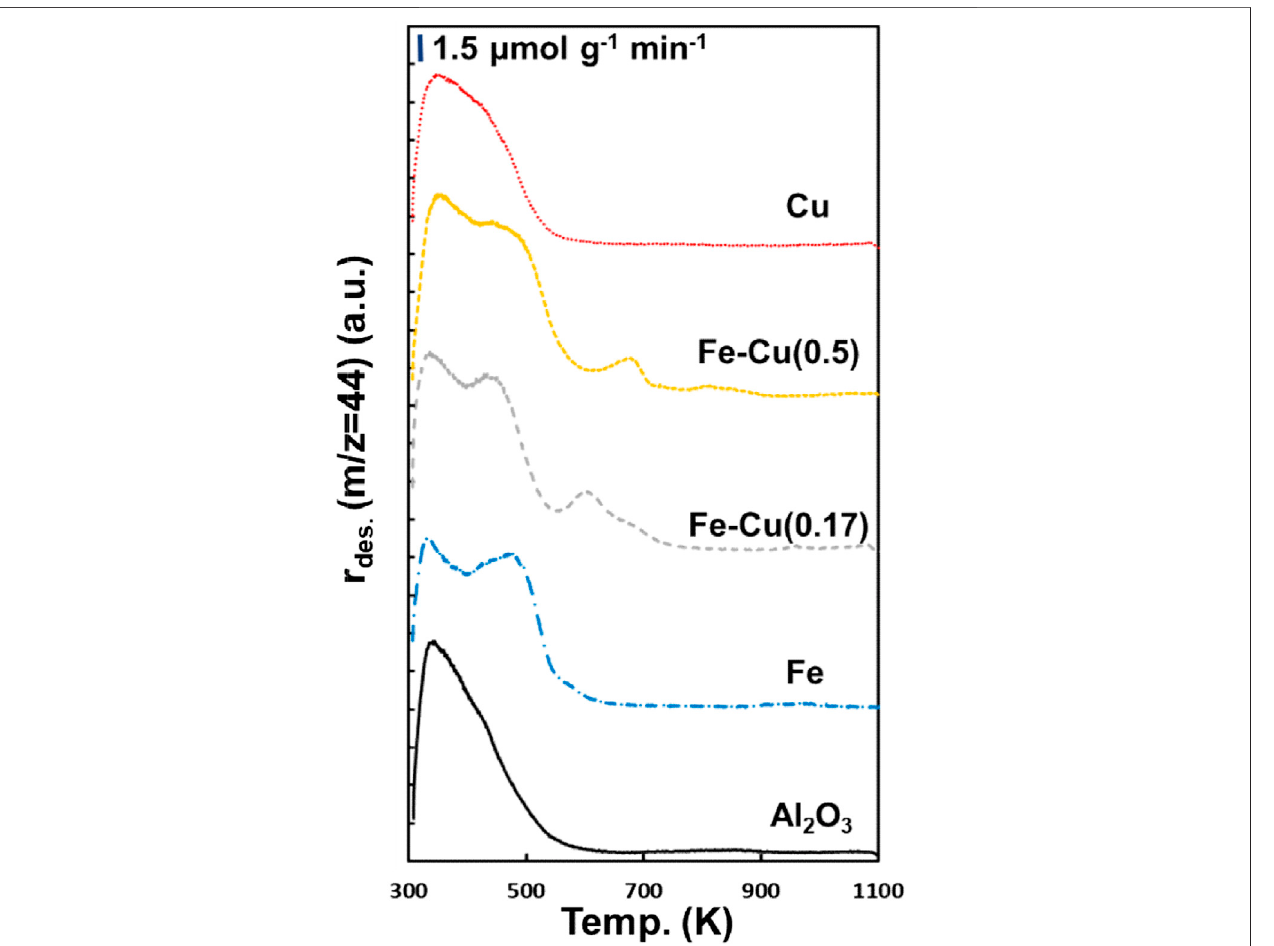
FIGURE 10 | CO 2 -TPD pro fi les of the reduced Fe-Cu(X)/Al 2 O 3 catalysts and the Al 2 O 3 support.